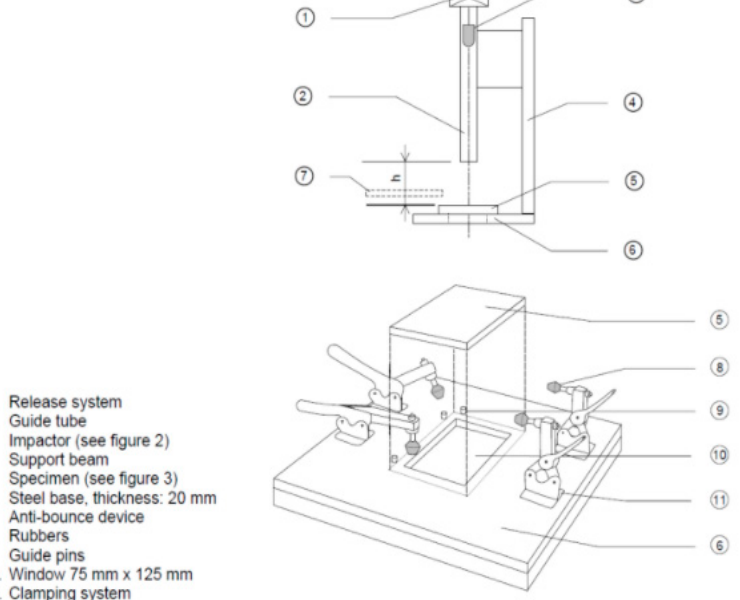
Figure 3. Test configuration for the low impact.